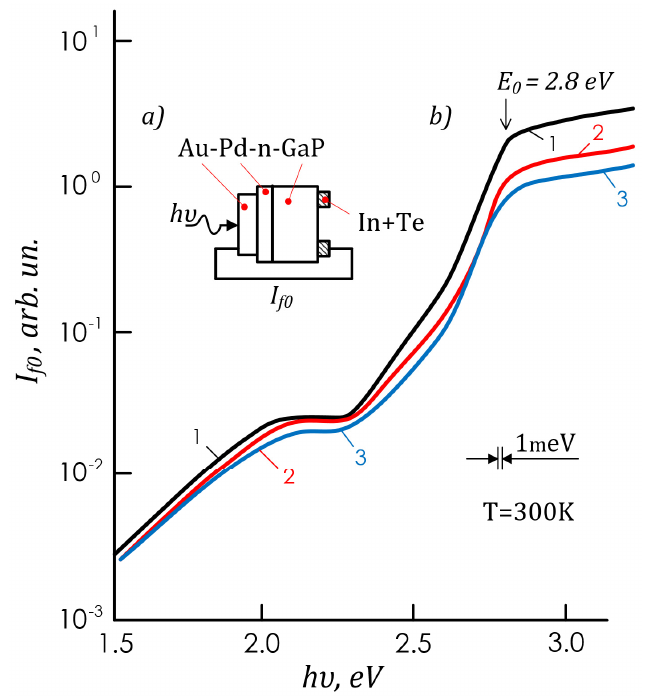
Figure 1. Diagram of a photodetector with lighting geometry (tab a); photocurrent spectra of surface-barrier structures Au-Pd-n-GaP with different thicknesses of the interlayer of palladium d. d: 1—40 Å ( β = 1.35); 2—32 Å ( β = 1.28); 3—45 Å ( β = 1.39) (tab b). The photocurrent related to an equality of incident photons.